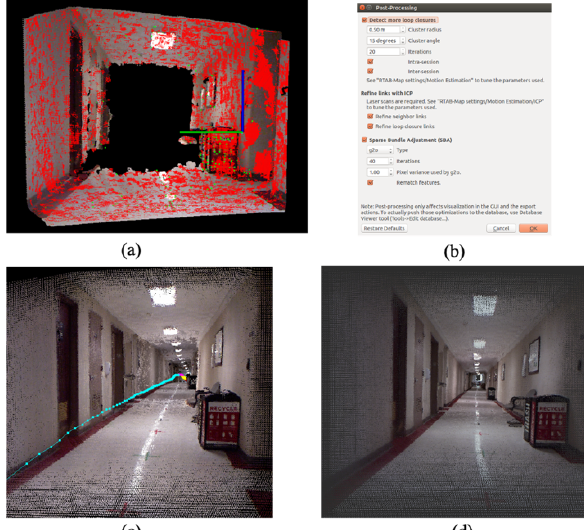
Figure 2. Workflow of proposed system.